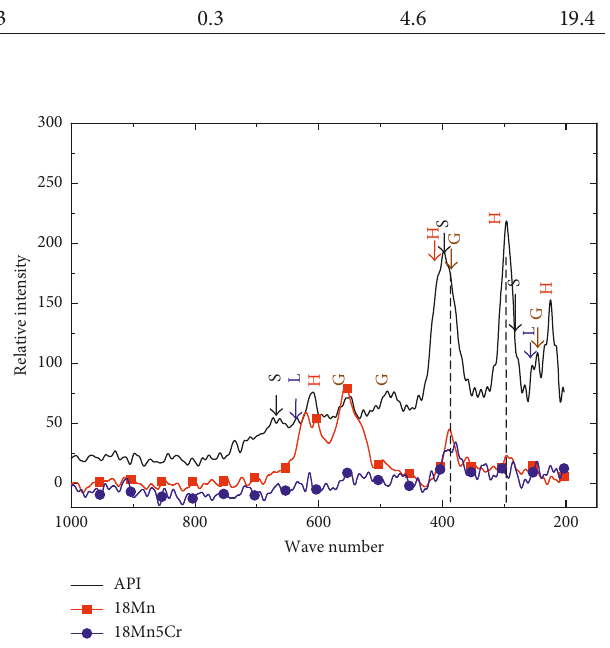
Figure 4: Raman spectra of the nonadherent rust (NAR) formed on REF, 18Mn, and 18Mn5Cr for 56 days in 3.5% NaCl solution at 60 ° C, where G, L, S, and H represent goethite, lepidocrocite, magnetite (or maghemite), and hematite, respectively. S: